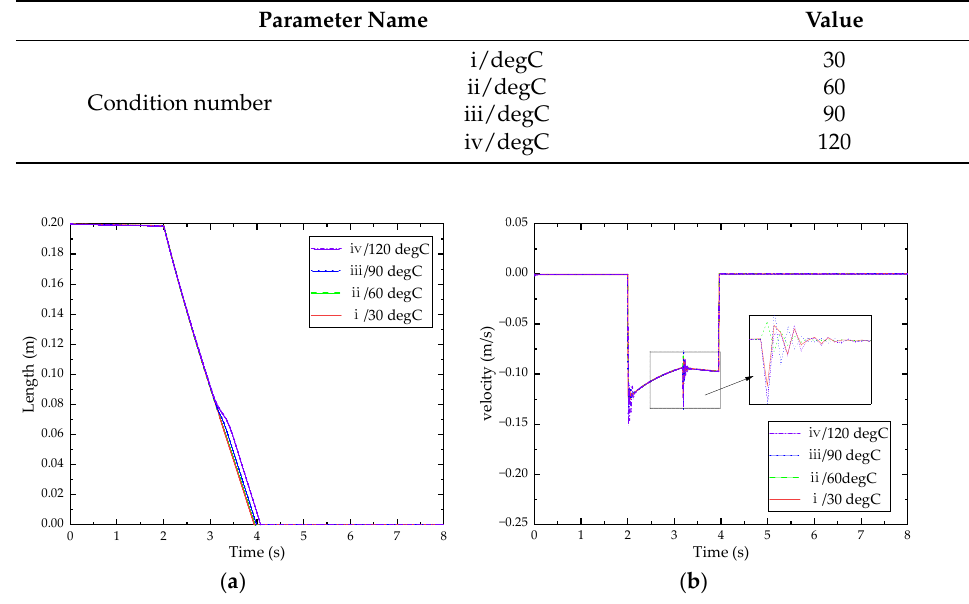
Figure 8. Effect of abnormal oil temperature: ( a ) Piston displacement; ( b ) Piston Velocity. (4) Oil filter blocked. There are three kinds of oil filters: suction line oil filters, return line oil filters, and pressure line oil filters, with the pressure line oil filter having the best filtering accuracy. The pressure line oil filter protects downstream hydraulic components while also filtering contaminants, which is critical. For fault simulation, the simulation specifies the diameter of the restrictor valve for pressure oil reaching the actuator as well as the number of parallel orifices of the oil filter. Table 7 shows the simulation parameters for the operating circumstances. Figure 9 pre- sents the results after running. Table 7. Oil filter blockage under different working conditions. Parameter Name ( b ) Figure 9. Effect of oil filter blockage: ( a ) Piston displacement; ( b ) Piston Velocity. While the actuator’s retraction time and stability might be affected to a certain extent as the amount of blockage grows, it will not cause serious problems if it is not completely blocked, as shown in Figure 9. A clogged filter element cannot be cleaned or reused and must be replaced at the appropriate time during operation. (5) Reversing valve spool stuck.